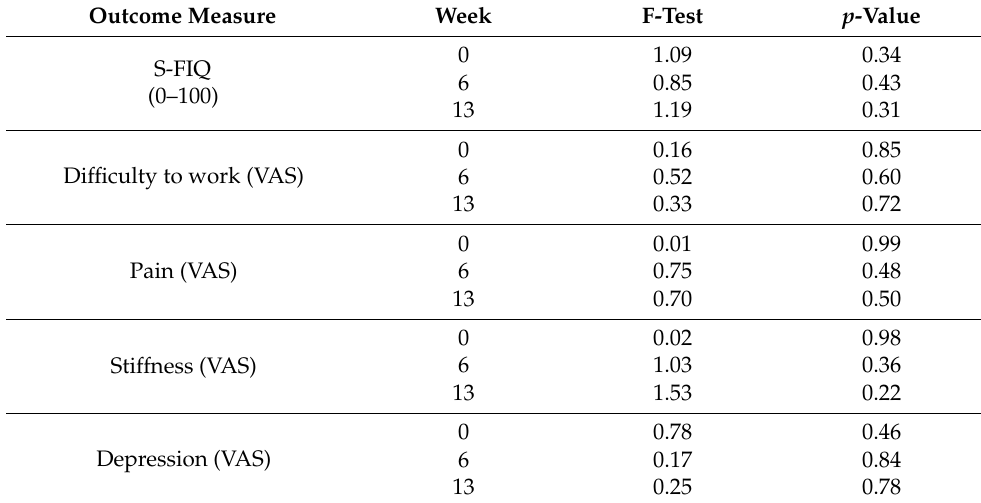
Table 3. Between-group differences in weeks 0, 6 and 13 (derived from one-way ANOVA in each